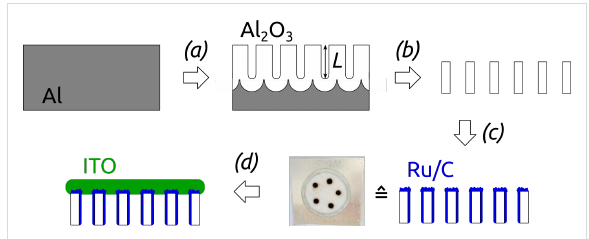
Figure 3: Photographs and schematic drawings of laser-induced chemical liquid deposition geometry on planar (a,b) and nanostruc- tured samples (c,d) from Ru 3 (CO) 12 solutions.